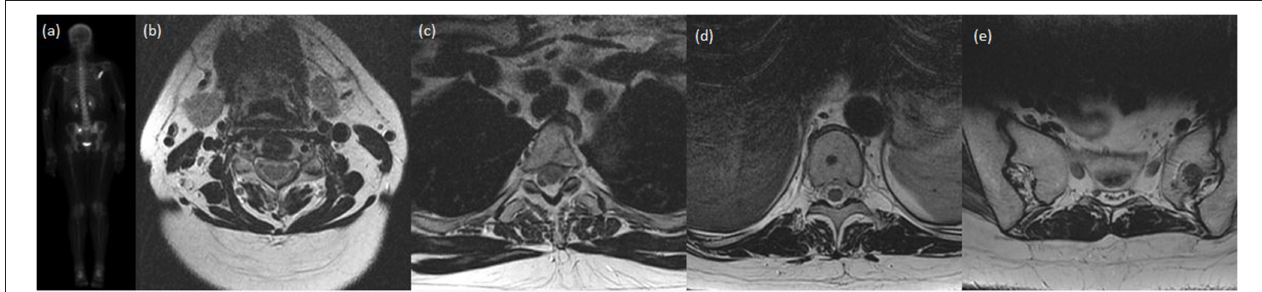
FIGURE 1 | A case presentation of a lady with invasive ductal carcinoma of the breast who was treated definitively with lumpectomy, adjuvant chemotherapy, and adjuvant radiotherapy. Shortly after completion of therapy, on re-staging investigations, she was found to have oligometastatic disease in the bones, specifically at C4, T3, T10, the left sacral ala, and right scapula. She received SBRT to each site and was started on hormonal therapy. At most recent follow-up 20 months later, she has not had progression of known disease nor interval development on new metastatic disease. (a) Posterior-anterior projection of pre-treatment bone scan demonstrating increased uptake within the right scapula, T3 and the right sacral ala. Subsequent images of axial slice of T2-weighted MRI demonstrating near complete marrow replacement of C4 (b) , focal marrow abnormality in posterior T3 body (c) , rounded focus centrally of the T10 vertebral body (d) , and 13mm lesion of left sacral ala (e)